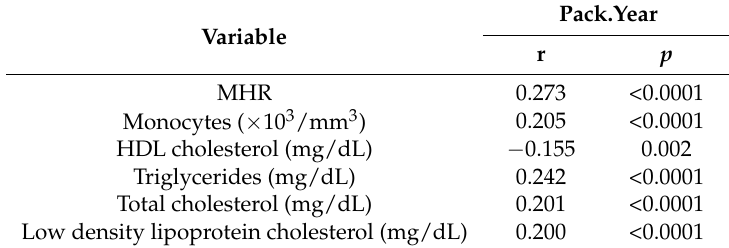
Table 3. Pearson’s correlation analysis between smoking as pack.year, MHR and blood lipid